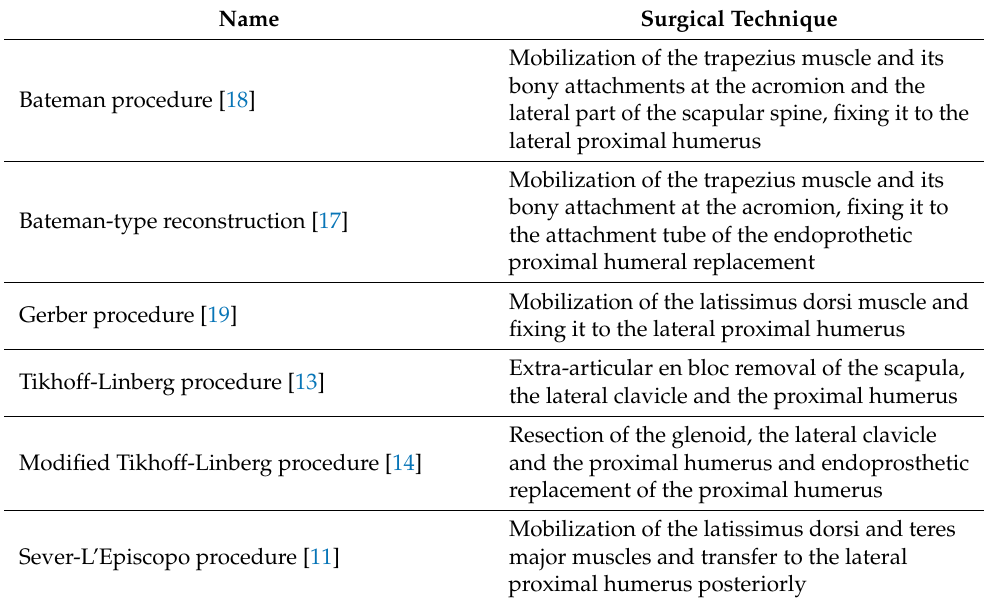
Table 1. Exemplary overview of different surgical techniques to reconstruct soft tissues in proximal humeral endoprosthetic